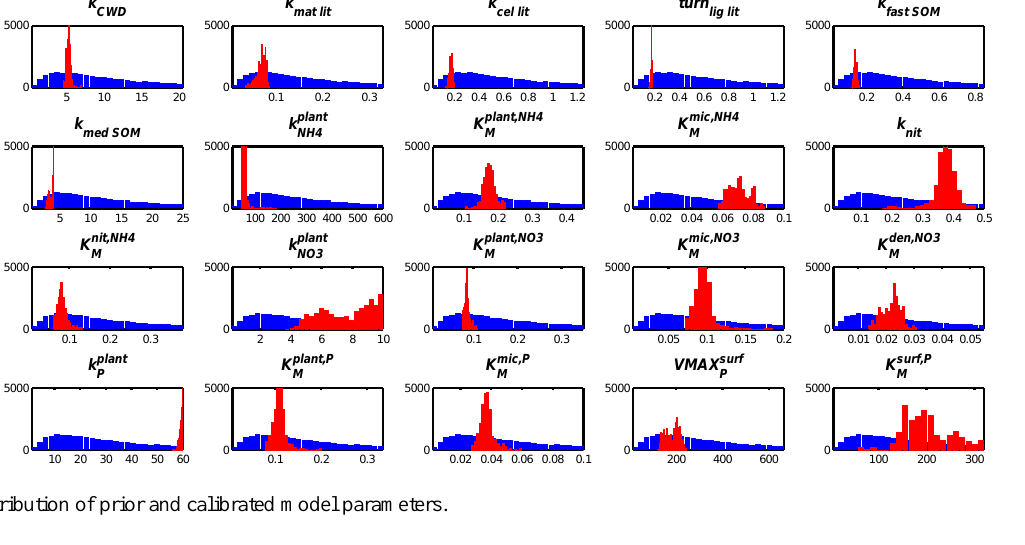
Figure 2. Distribution of prior and calibrated model